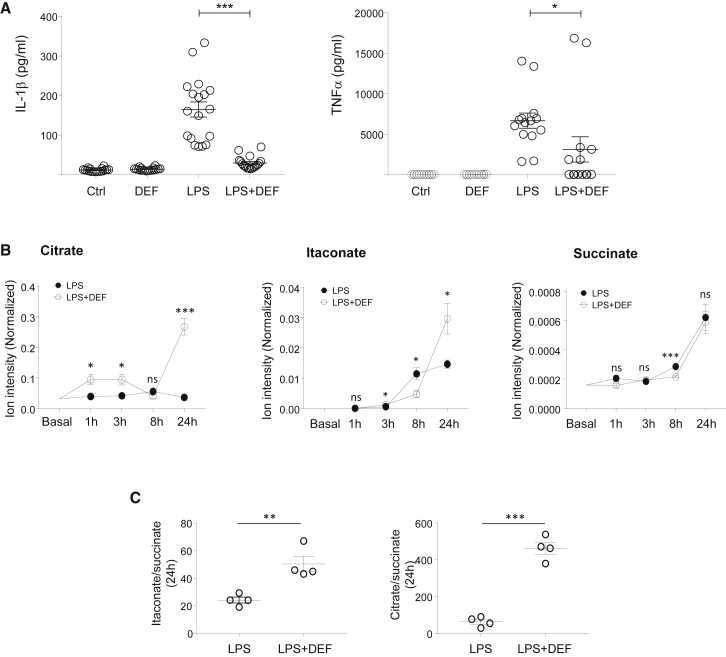
Acute Iron Chelation Limits the Pro-inflammatory Macrophage Polarization(A) IL-1β and TNF-α production in iron-deprived human macrophages (500 μM, 24 h), following LPS treatment (100 ng/mL, 24 h; LPS + DEF); n = 7 donors.(B) LC-MS for citrate, itaconate, and succinate in basal and DEF-treated macrophages (500 μM, 24 h) throughout an LPS (100 ng/mL) time course; n = 4 donors.(C) Itaconate:succinate and citrate:succinate ratios at 24 h; n = 4 donors.Significance tested by ANOVA followed by Tukey’s multiple comparisons test (A) and t test (B and C). ∗p < 0.05, ∗∗p < 0.01, and ∗∗∗p < 0.001. Error bars represent SEM.See also Figure S5.